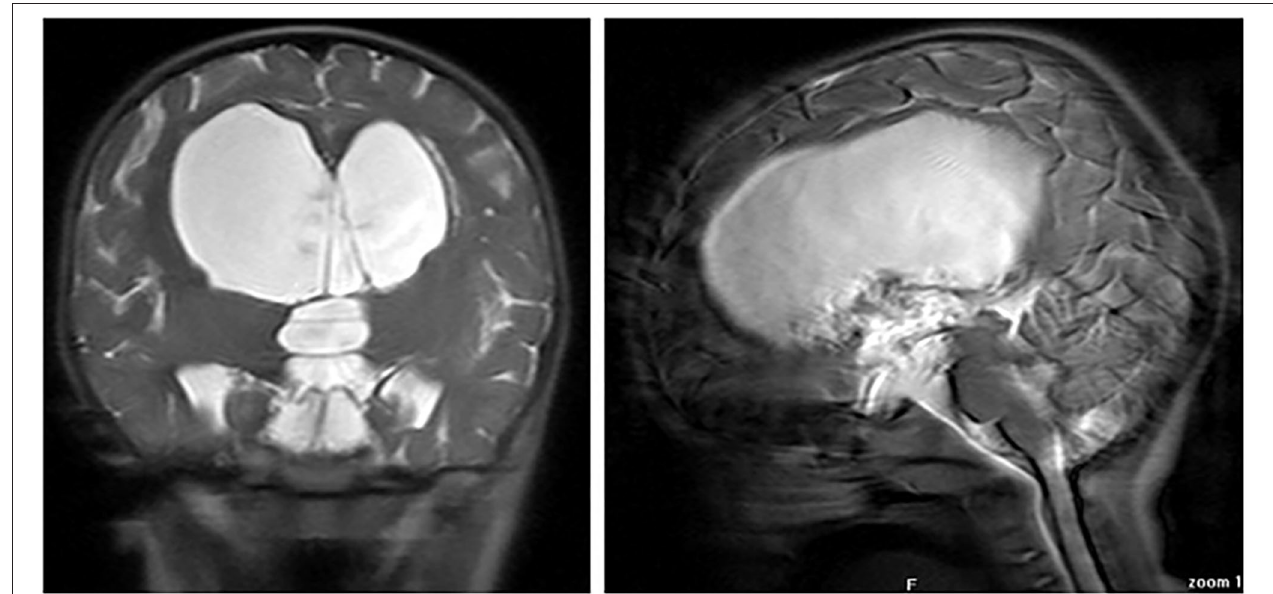
FIGURE 1 | Coronal (right) and sagittal (left) MR images at diagnosis, showing large suprasellar arachnoid